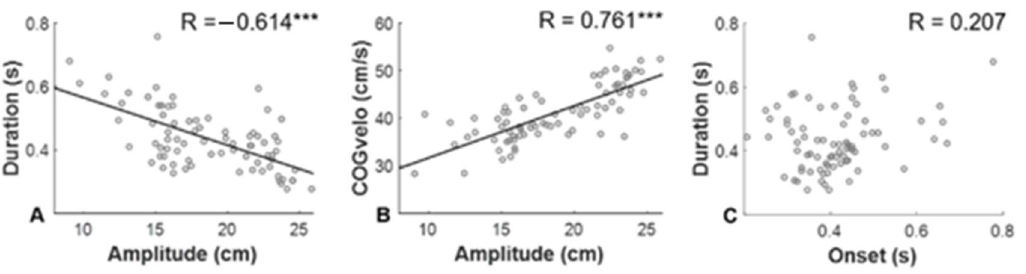
Figure 4. The relationship between measurement parameters. A circle represents the mean value of each condition for a participant. The correlation coefficient (R) and level of significance are indicated (*** p < 0.001). ( A ) APA amplitude negatively correlated with APA duration (R = − 0.637, p < 0.001). ( B ) APA amplitude significantly correlated with COG velo (R = 0.761, p < 0.001). ( C ) APA onset was not correlated with APA duration.